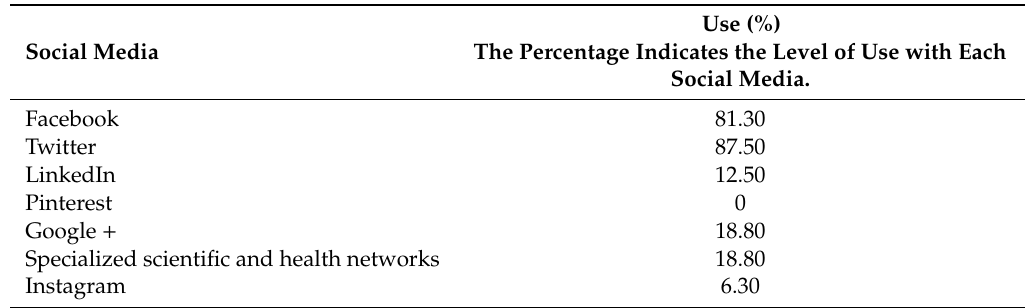
Table 8. Social media used most